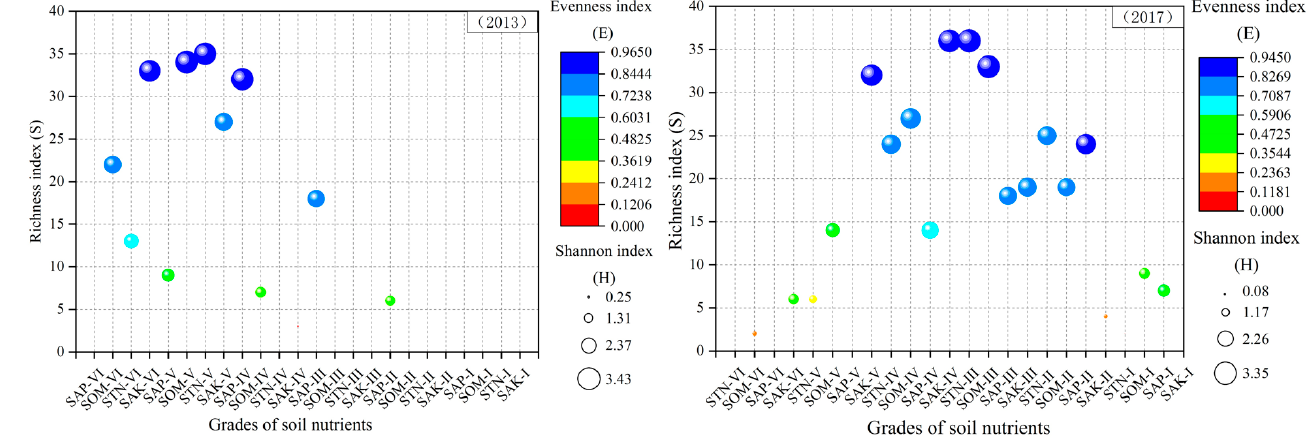
Figure 5. Distribution diagram of the diversity index of different soil nutrient grades in the study area. Table 2. Diversity indices of soil nutrient grades under different land-use